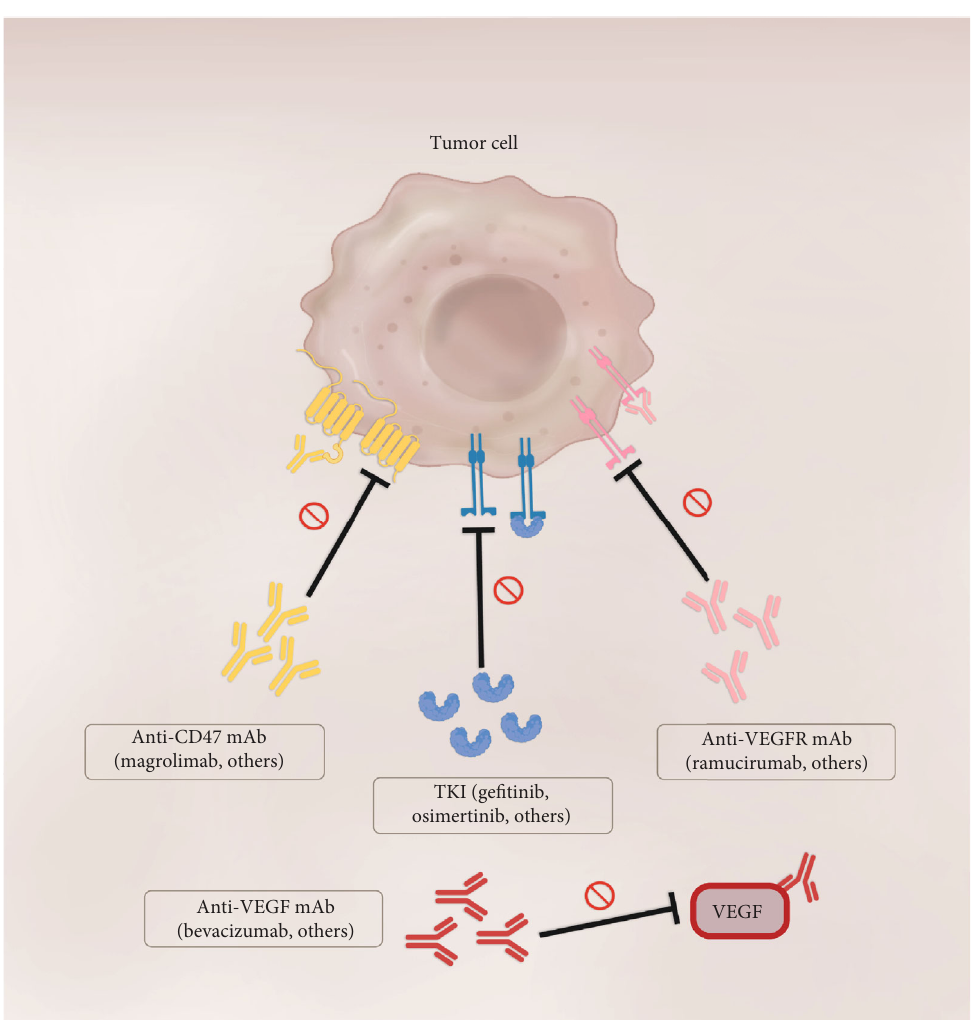
Figure 2: Promising treatment combinations of anti-CD47 drugs and current e ff ective therapies for NSCLC. The inhibition of the CD47- SIRP α axis with anti-CD47 mAb can induce antitumor immunity through various mechanisms. Combining anti-CD47 with TKIs might be bene fi cial for two reasons. First, EGFR inhibition has shown to signi fi cantly reduce CD47 expression. Second, the inhibition of CD47 could increase the clearance of TKI-resistant cells. Combining anti-CD47 with antiangiogenic therapy could likewise be useful, since CD47 blockade could sensitize NSCLC to the latter therapy and potentiate its antitumor e ff